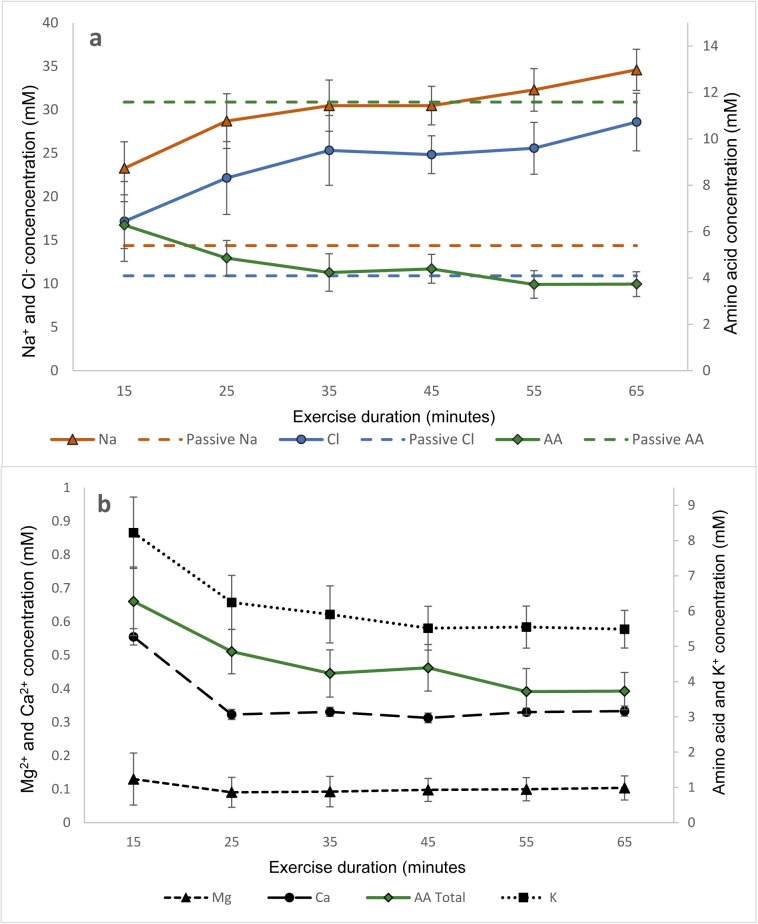
(a) Concentrations of Na+ and Cl- (primary axis) and mean total amino acid concentrations (secondary axis) in exercise sweat (mM) assessed at ten minute intervals from 15 to 65 minutes of exercise (n = 11). The concentrations of Na+, Cl- and total amino acids in passive sweat (n = 6) are also shown for reference on the respective axes. (b), Mg2+ and Ca2+ concentrations (primary axis) in exercise sweat for the exercise duration are shown with amino acid and K+ concentrations (secondary axis).